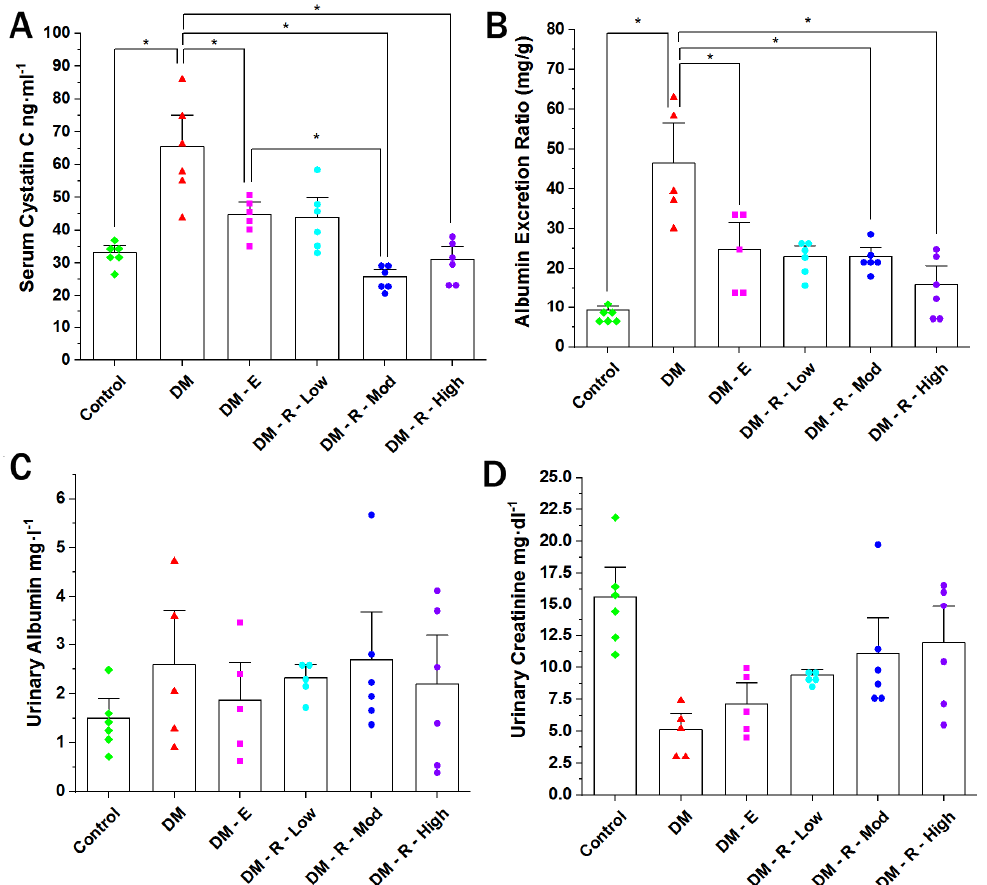
Figure 1. Effect of ruxolitinib on serum cystatin ( A ), albumin excretion ratio ( B ), urinary albumin ( C ), and urinary creatinine levels ( D ). ( A ) Cystatin C level in the sera of normal, diabetic treated, and non-treated male Wistar rats. (B) Bar graph showing urinary albumin excretion of normal (control), diabetic treated, and non-treated male Wistar rats ( n = 6). Data are represented as individual values for each mouse (dots). Statistical significance is shown by asterisks (* p < 0.05). The difference among groups was assessed by the Kruskal–Wallis test followed by the Mann–Whitney U test for post hoc group binary comparisons. DM, diabetic non-treated group, DM-E, diabetic enalapril-treated group (10 mg·kg − 1 ), DM-R-Low, diabetic ruxolitinib-treated low-dose group (0.44 mg·kg − 1 ), DM-R-Mod, diabetic ruxolitinib-treated moderate-dose group (2.2 mg·kg − 1 ), DM-R-High, diabetic ruxolitinib-treated high-dose group (4.4 mg·kg − 1 ).